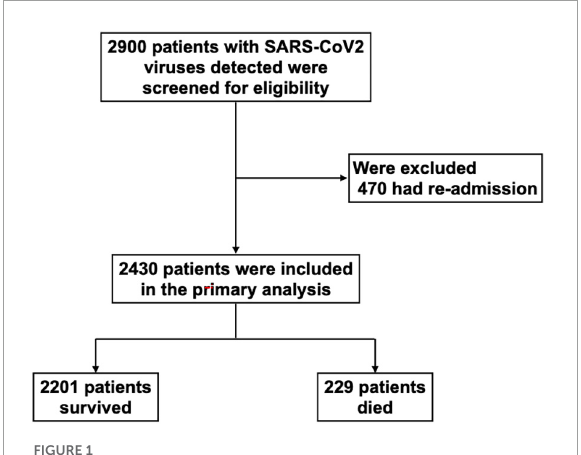
FIGURE1 Study population. SARS-CoV-2, severe acute respiratory syndrome